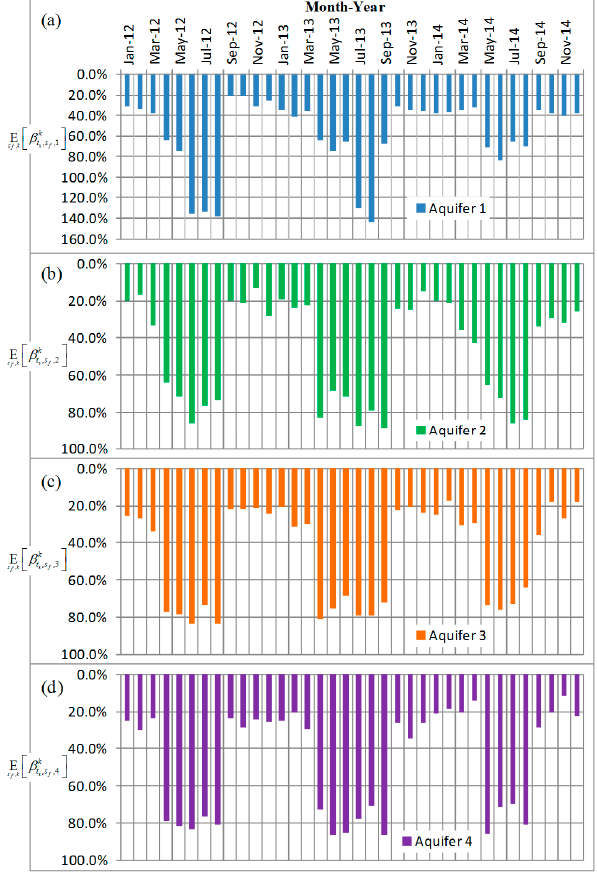
(cid:20) (cid:21) β k hyetograph across four hyetograph across four aquifers. Figure 10. The calculated E t s , s f , f   s f , k